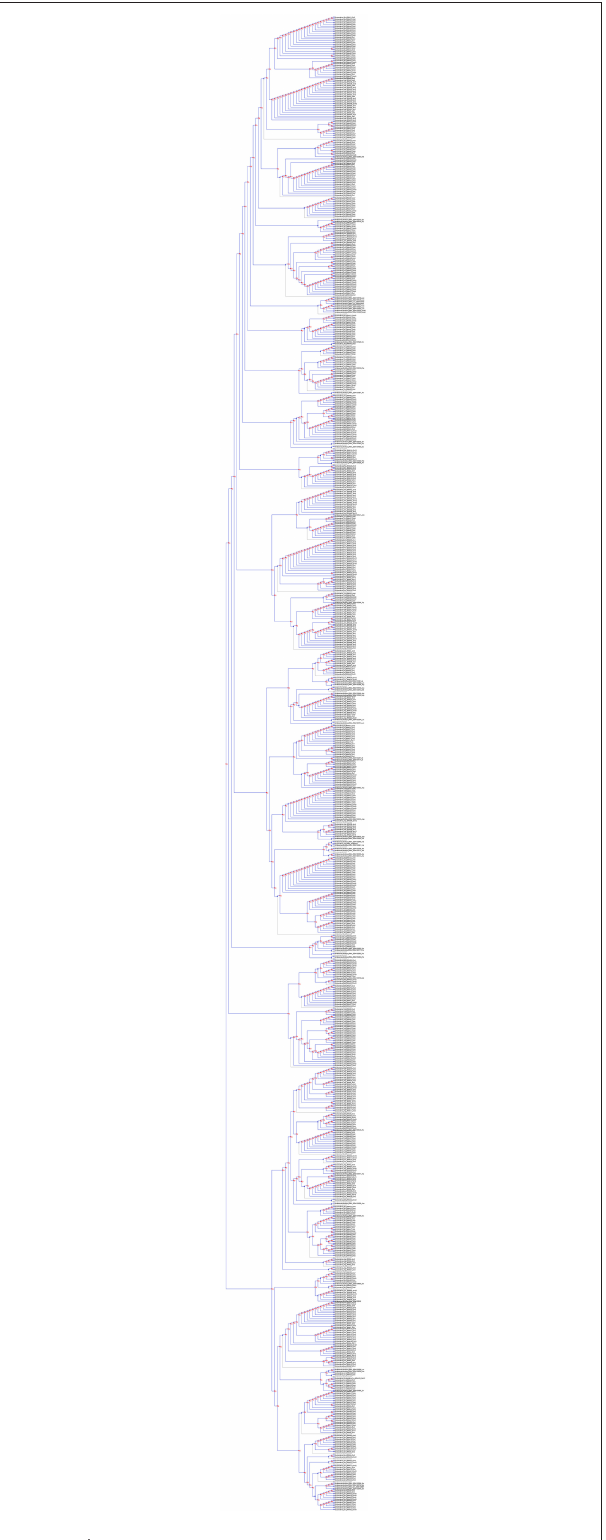
FIGURE 8 | Loss of O. sativa tRNAs study revealed 17 O. sativa tRNA were lost the during evolution. tRNA loss was conducted using Notung 2.6